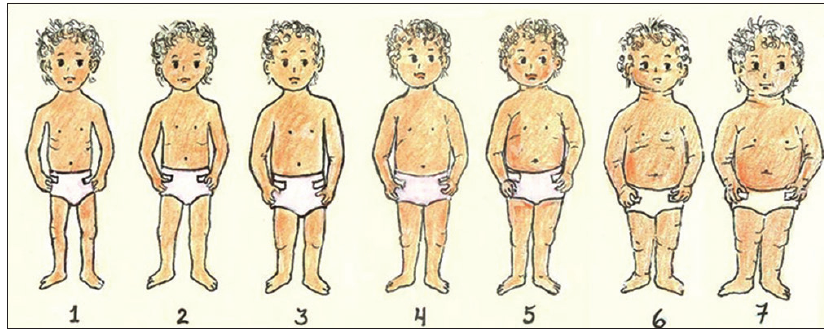
Figure 1 : Toddler Silhouette Scale: 1- Underweight, 2-5 Normal, 6-7 Overweight Adapted from: Hager ER McGill AE, Black MM. Development and validation of a toddler silhouette scale. Obesity. 2010;